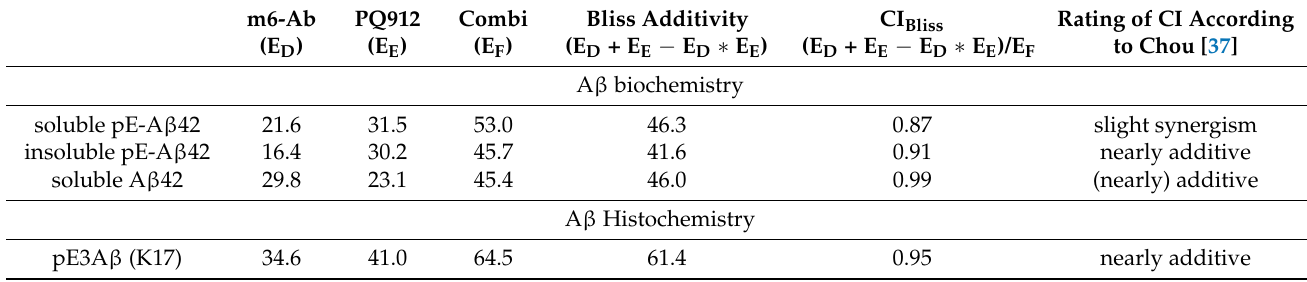
Table 1. Quantitative evaluation of the combination treatment with PQ912 and m6-Ab for 16 weeks, applying the Bliss model. The parameters are: % mean response (E x = % decrease of A β in respective group x compared to isotype control) for different groups, and calculated Bliss additivity and Bliss combination index (CI Bliss ) for A β 42 and pGlu-A β 42 in soluble and insoluble brain fractions; CI Bliss are given, if a robust (significant ANOVA) effect on A β level was observed (compare to Figures 1 and 2).